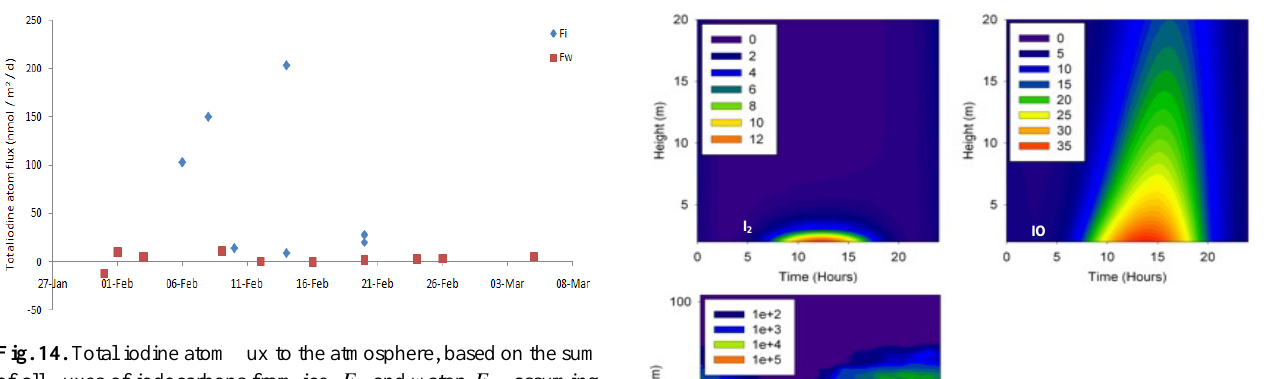
Fig. 13. Iodocarbon concentrations measured (a) in overlying air and (b) by drawing air through a Teflon-lined tube pushed 20 cm into the snowpack, on the Brunt Ice Shelf.